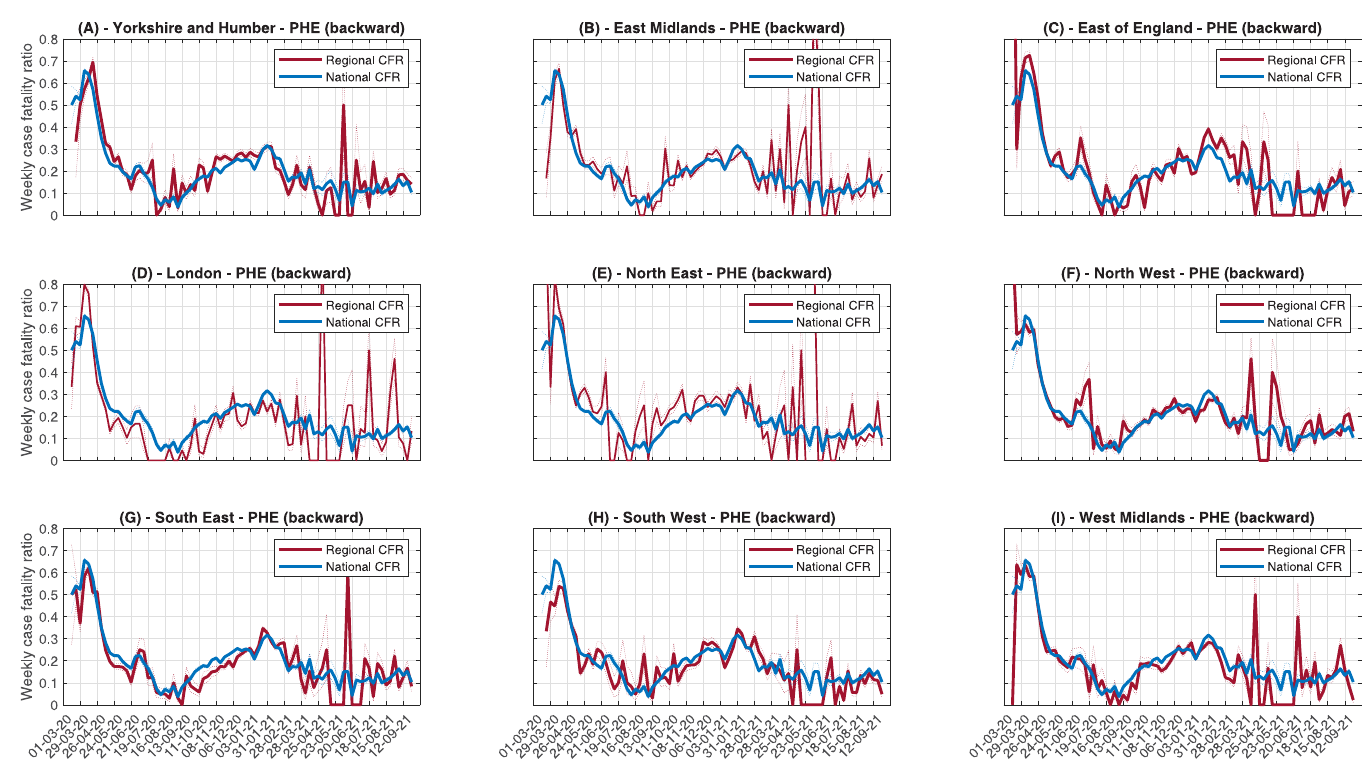
Fig 8. Comparing weekly CFR trends across English regions, using PHE data and the backward method. Each panel contains the regional trend and the national trend.